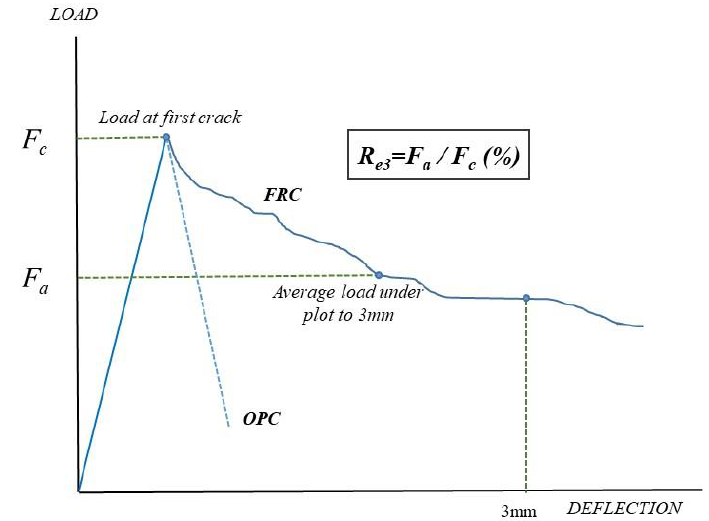
Figure 2. Calculation of residual stress (JSCE Figure 2 . Calculation of residual stress (JSCE SF-4). Figure 2 . Calculation of residual stress (JSCE SF-4).